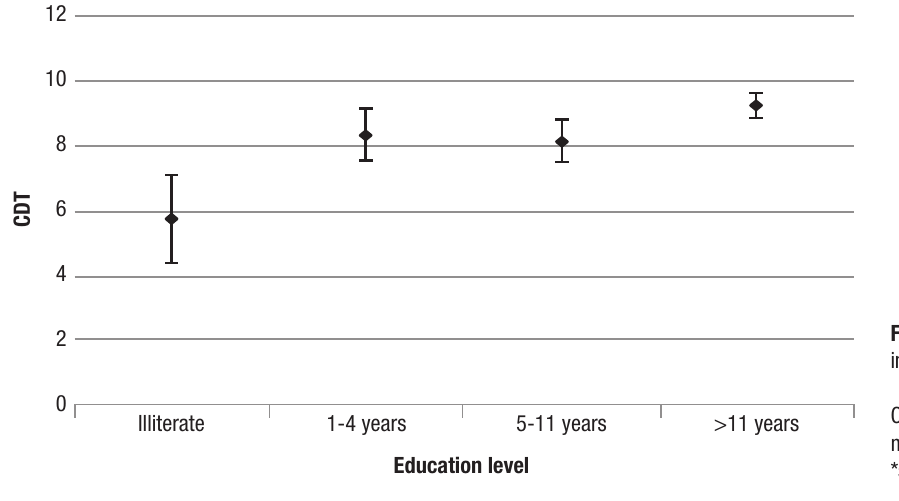
Table 2. Results on Tukey’s multiple comparisons test for groups with different educational